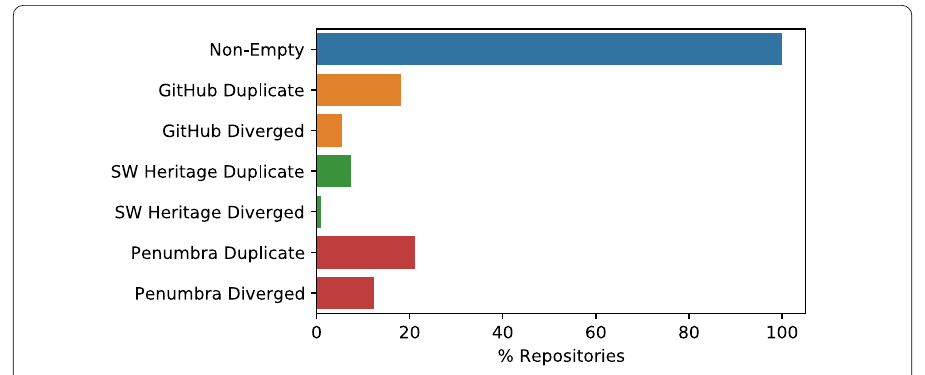
Figure 7 The Penumbra’s intersection with other datasets. Of the 55,343 discovered, non-empty repositories, 18% have a first commit hash that can also be found on GitHub (GitHub Duplicate), but 30% of those repositories diverge and contain code not found on GitHub (GitHub Diverged). Likewise, 7% of Penumbra repositories have a first commit archived by Software Heritage [1], and 14% of those contain code